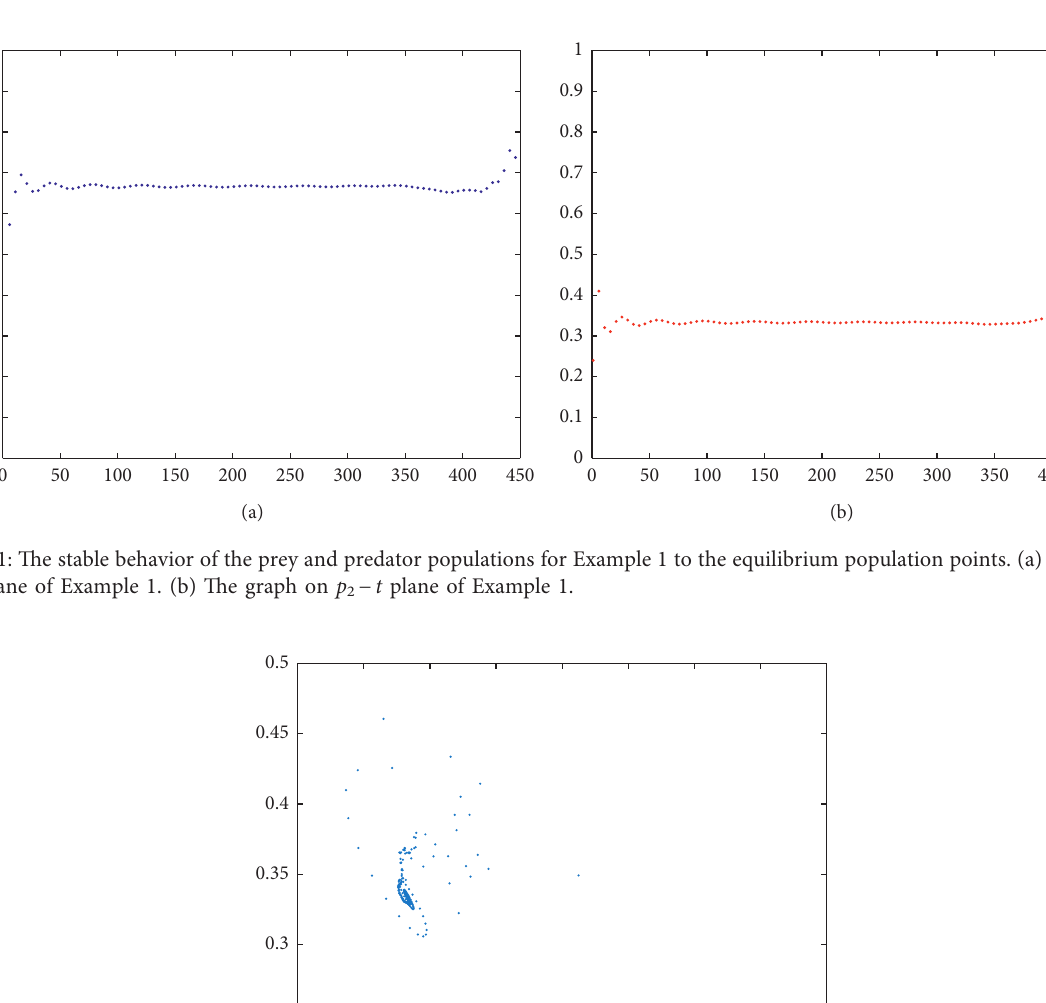
� ( 2/3 ) and p ∗ � ( 1/3 ) 1 2